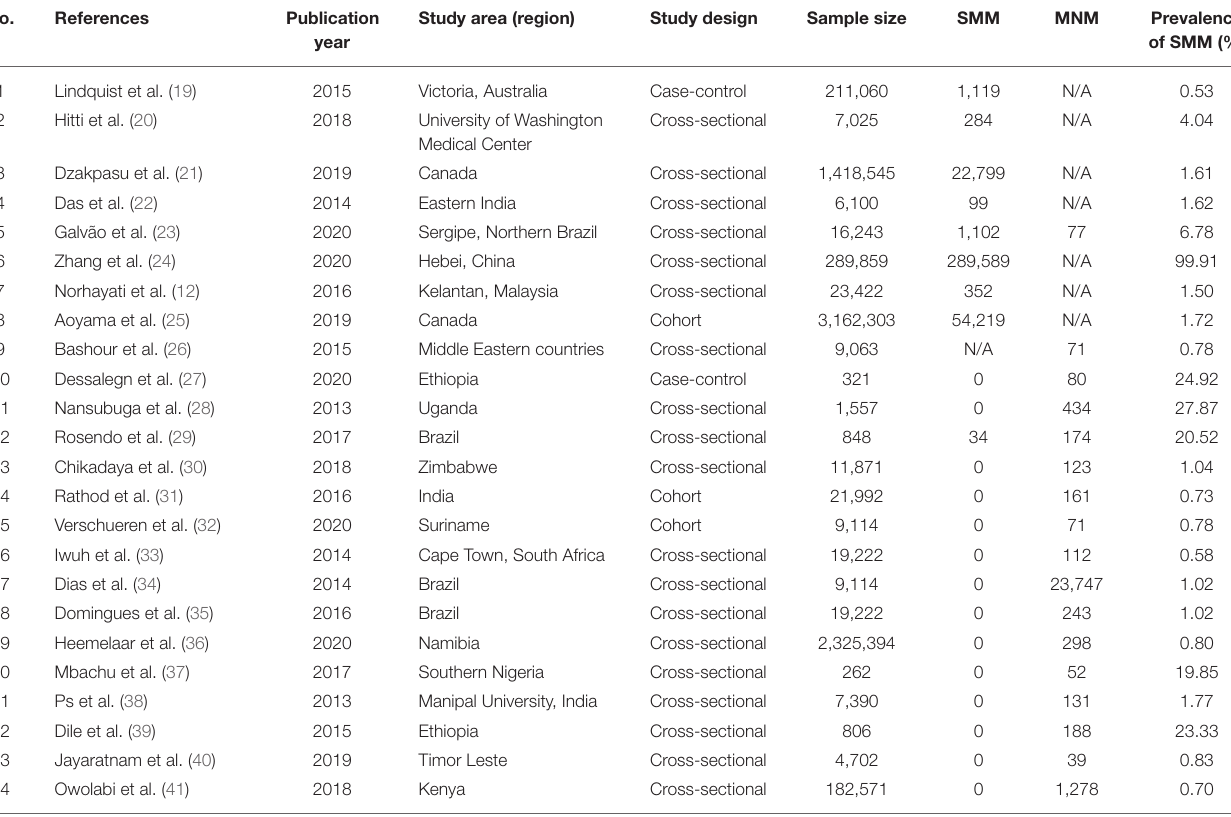
TABLE 1 | Summary of research articles included in the systemic review and meta-analysis for SMM and MNM ( n = 24). No.